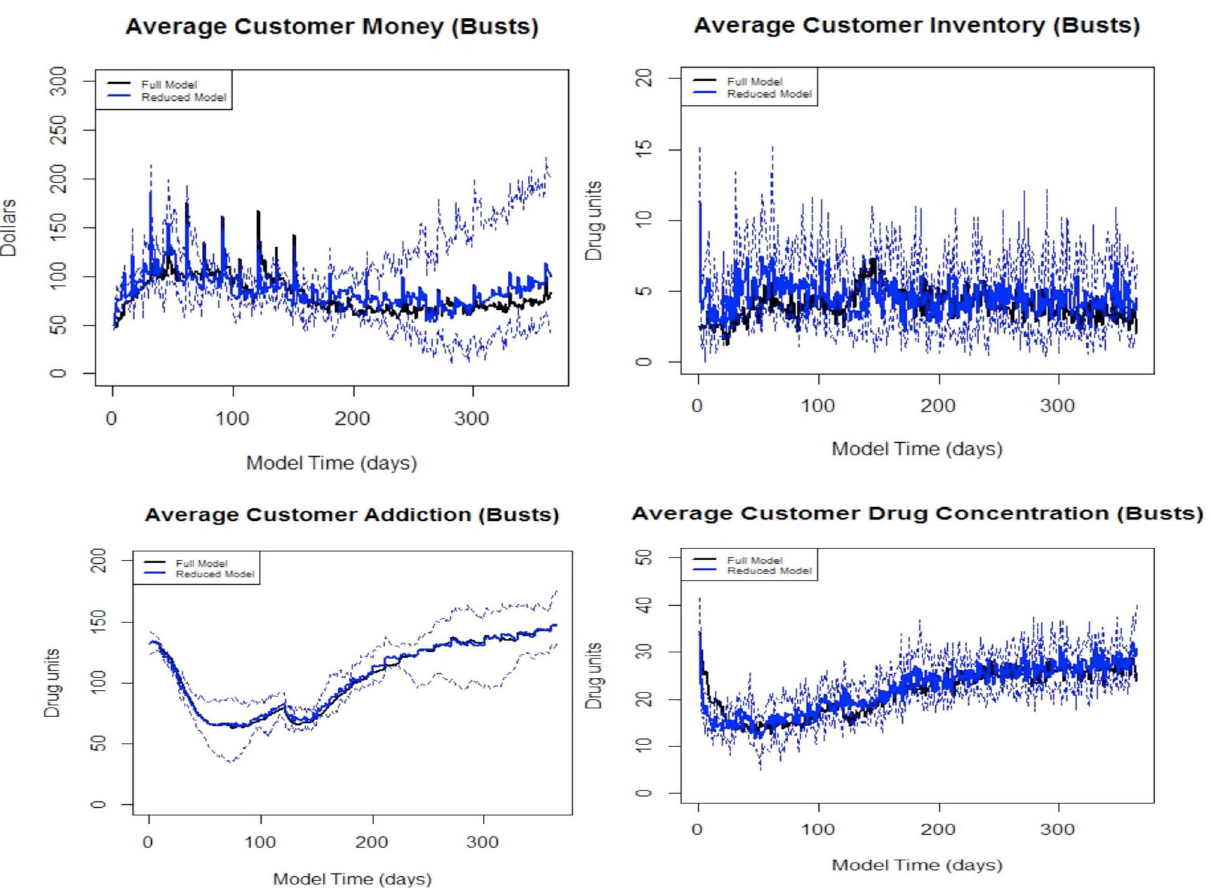
Figure 10. Comparison of full and reduced models including busts. Dotted lines represent 95% intervals for reduced model output.